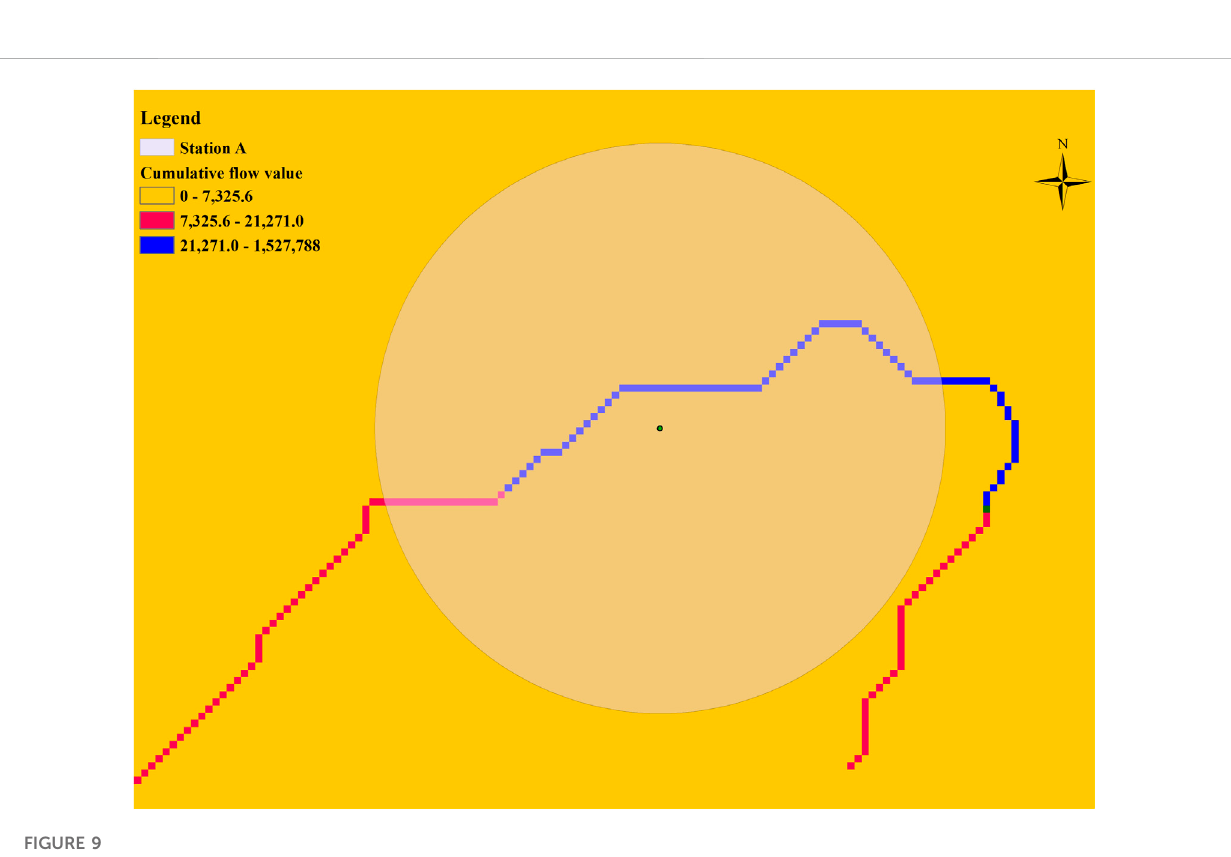
FIGURE 9 Cumulative value of fl ow in the area of station